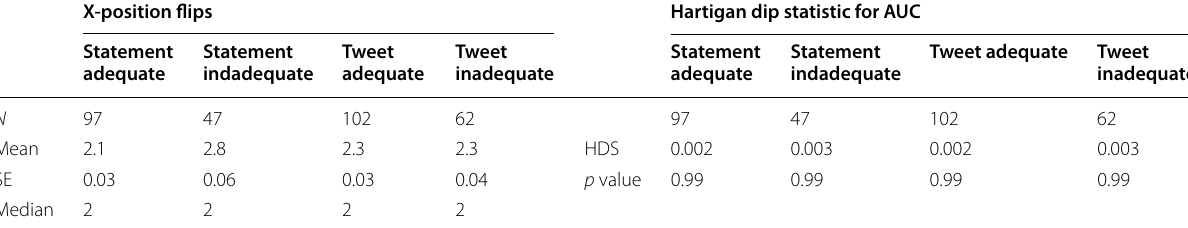
Table 1 Descriptive statistics—uncertainty and bimodality for Experiments 1 and 2 X-position flips